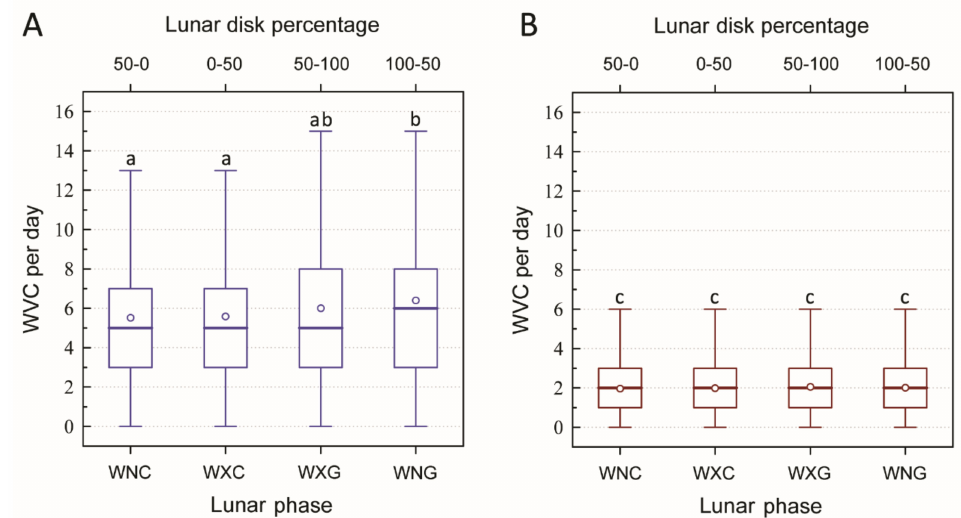
Figure 1. Wildlife–vehicle collisions (WVCs) per day during different lunar phases. ( A ) = dark period (night—sunset to sunrise); ( B ) = light period (day—sunrise to sunset). Lunar phases are arranged by the percentage of lunar disc: waning crescent (WNC), waxing crescent (WXC), waxing gibbous (WXG), and waning gibbous (WNG). Thick lines indicate medians, open circles indicate means, boxes indicate inter quartile ranges, and whiskers indicate non-outlier ranges. Lowercase letters (above the whiskers) indicate statistical significance (Mann–Whitney U test ( p < 0.05))—phases with the same letter are not statistically different from each other, while phases with different letters are statistically significant from each other.